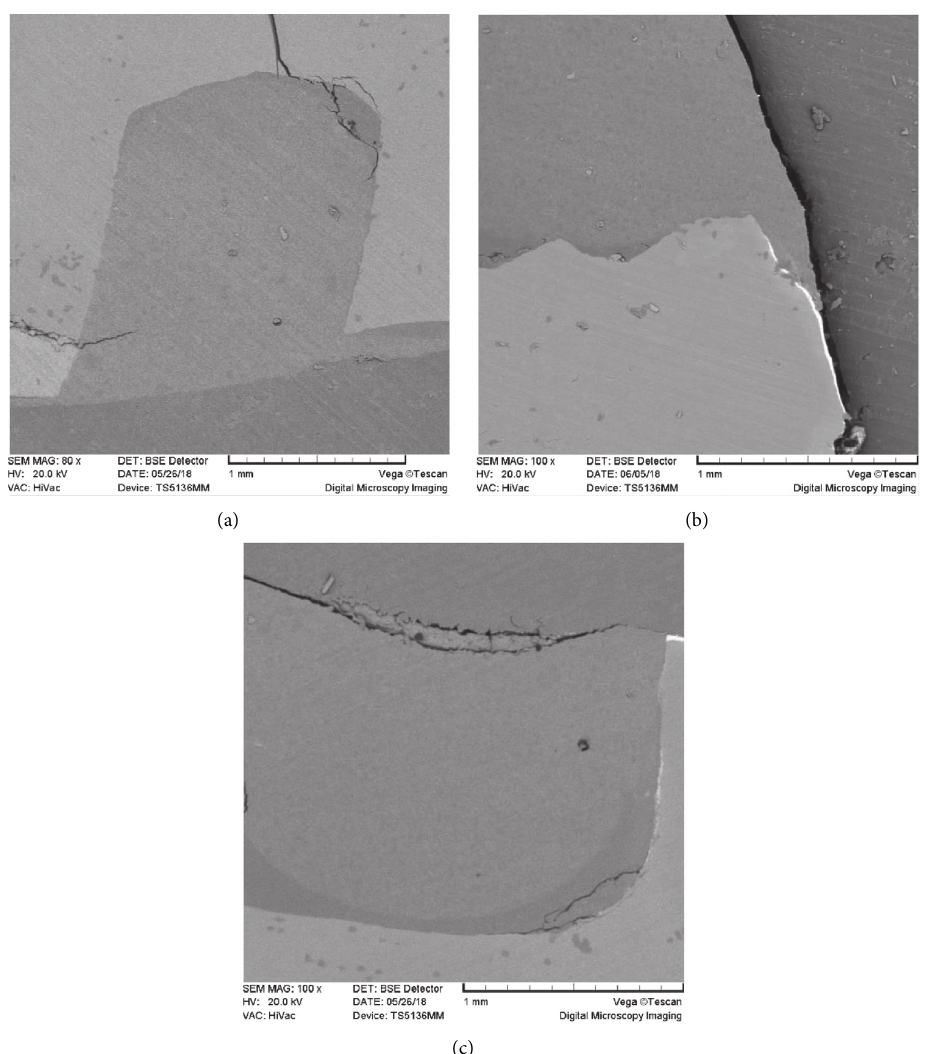
Figure 4: Marginal leakage on coronal and gingival walls detected by SEM (Cam-Scan MV2300; Slovakia). (a) Marginal leakage, score 0, on the coronal and gingival walls, 60x. (b) Marginal leakage, score 1, on the gingival wall, 100x. (c) Marginal leakage, score 2, on the gingival wall,